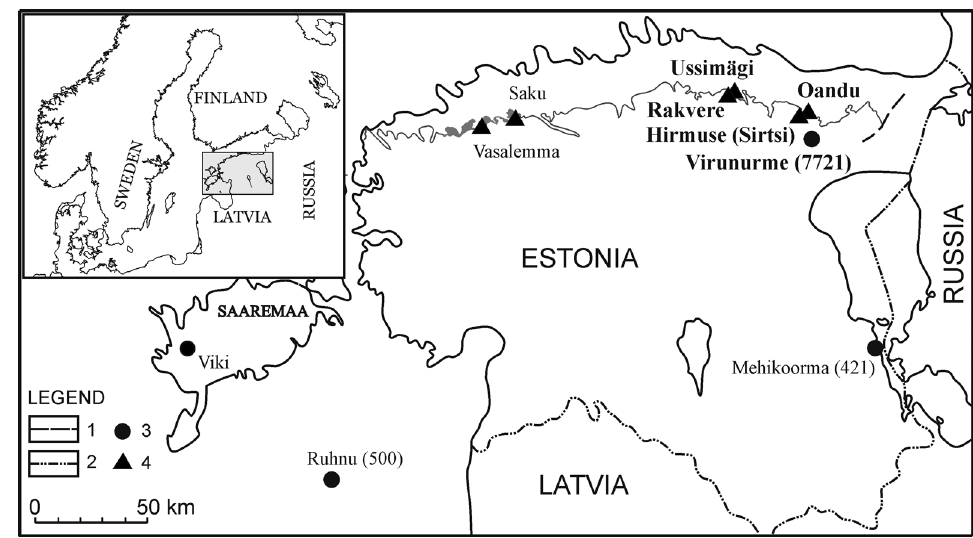
Fig. 1. Location of the sections discussed or referred to in the text. Names of the sections from where conodonts were analysed during this study are in bold. Legend: 1, fault; 2, state boundaries; 3, core section; 4, outcrop section. The grey line corresponds to the outcrop belt of the strata of Oandu age (after Bedrock Geological Map of Estonia , Geological Survey of Estonia